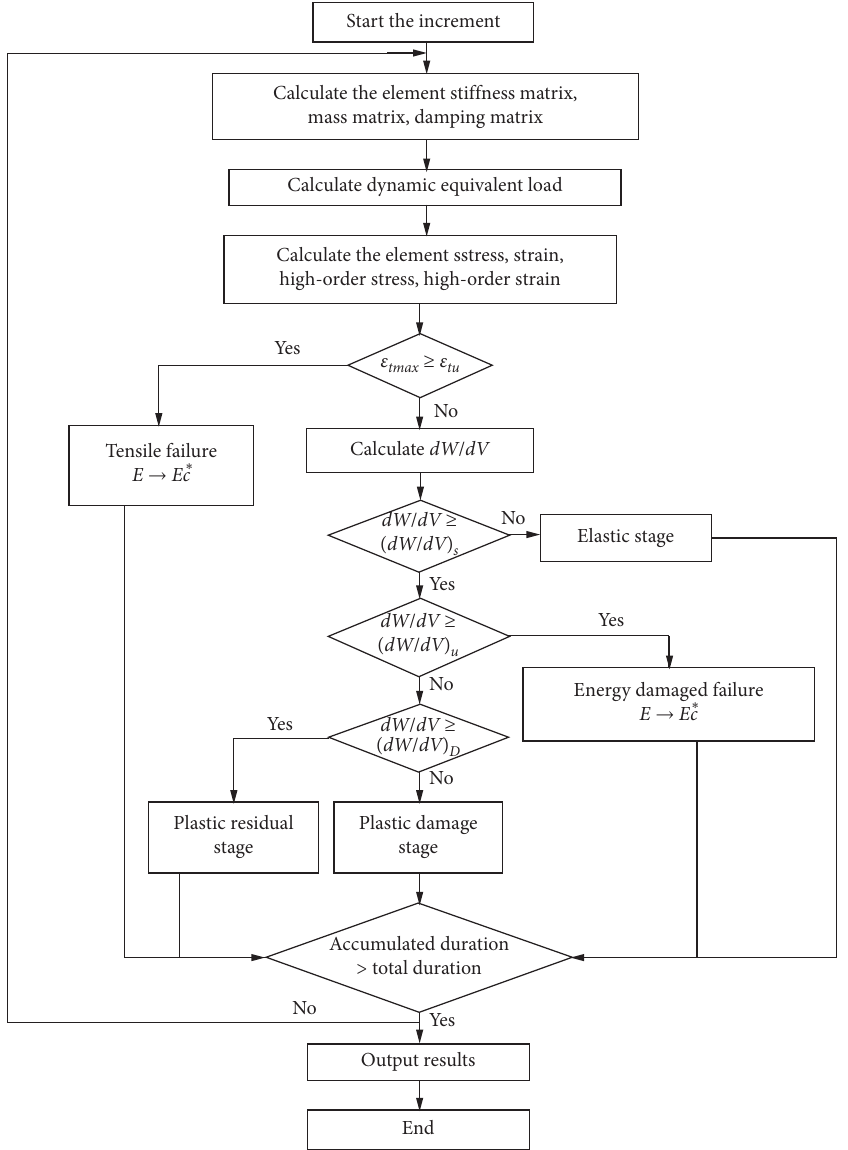
Figure 10: Flow chart of zonal disintegration subroutine.